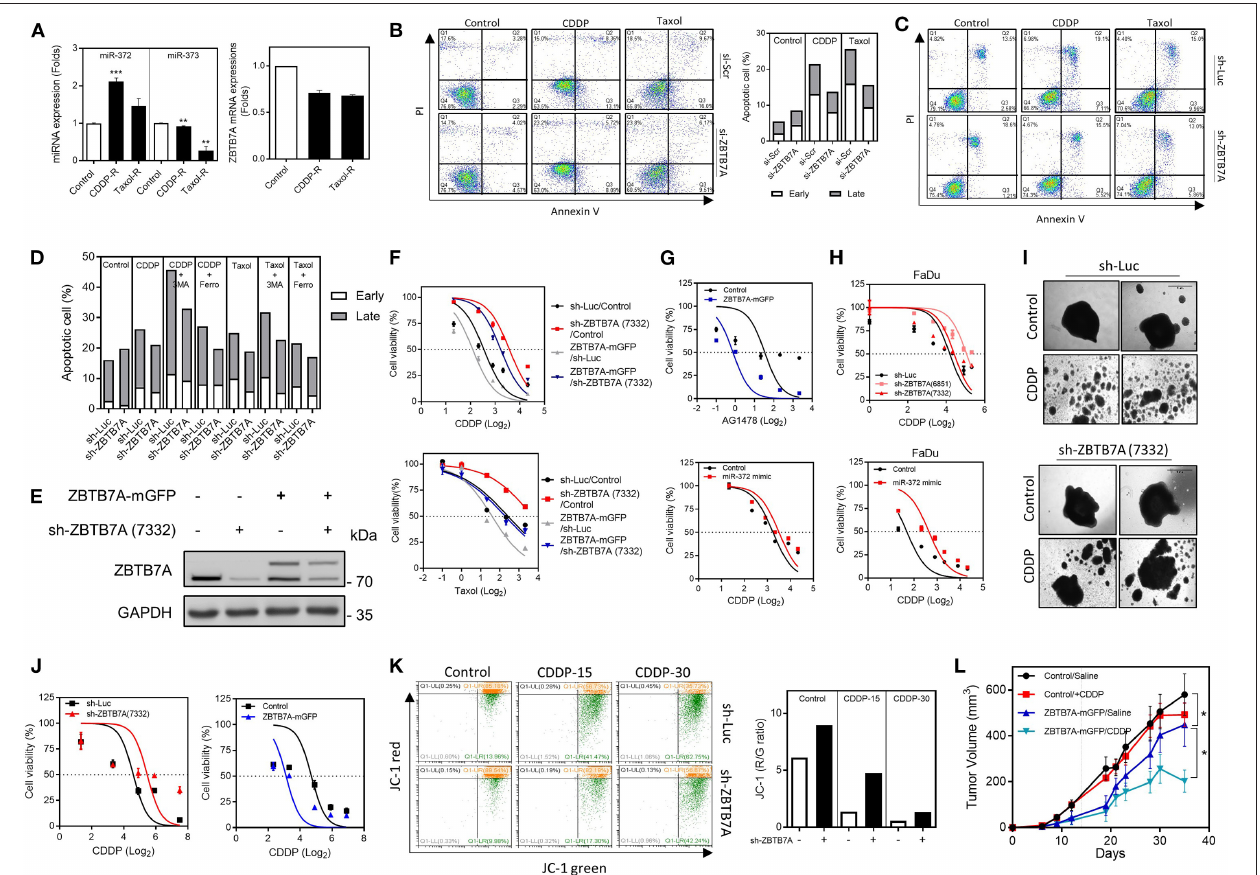
FIGURE 3 | ZBTB7A expression is associated with apoptosis and drug sensitivity in OSCC cells. (A–G,I–L) SAS cells. (H) FaDu cells. (A) Lt, Increased miR-372 expression in CDDP resistance (CDDP-R) and taxol resistance (taxol-R) SAS cell subclones relative to the parental cells. Rt, ZBTB7A expression is slightly downregulated in these cell subclones. (B,C) Apoptosis assay. Cells with transient ZBTB7A knockdown (in B , Lt), as well as the stable knockdown cell subclone (in C ), were treated with CDDP or taxol to induce apoptosis. (B) Rt, quantification of the presence of apoptotic cells. Lt, ZBTB7A knockdown decreases the